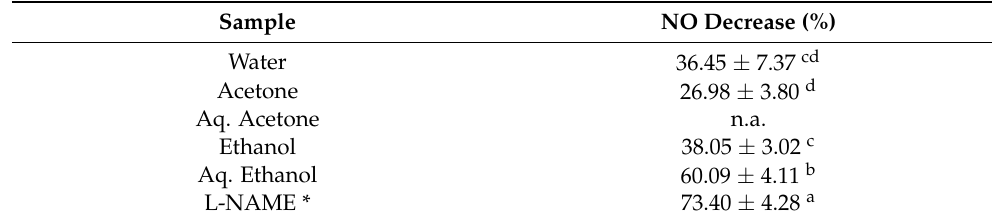
Table 5. Anti-inflammatory activity (% NO decrease) of extracts from Cladium mariscus (saw- grass)